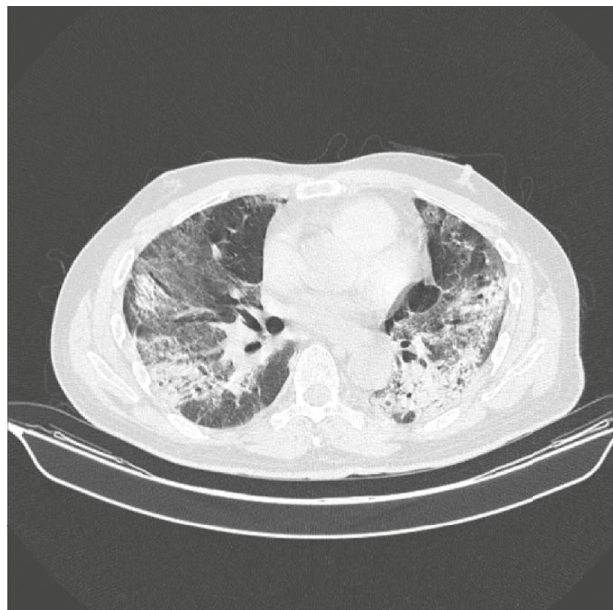
Figure 1: HRCT illustrating severe organising pneumonia with fibrotic-like